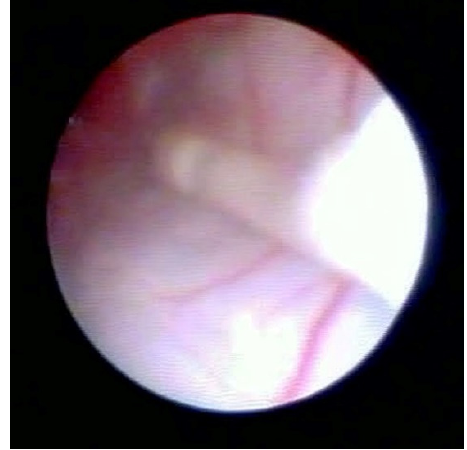
Figure 2. Normal dura, root lifting.